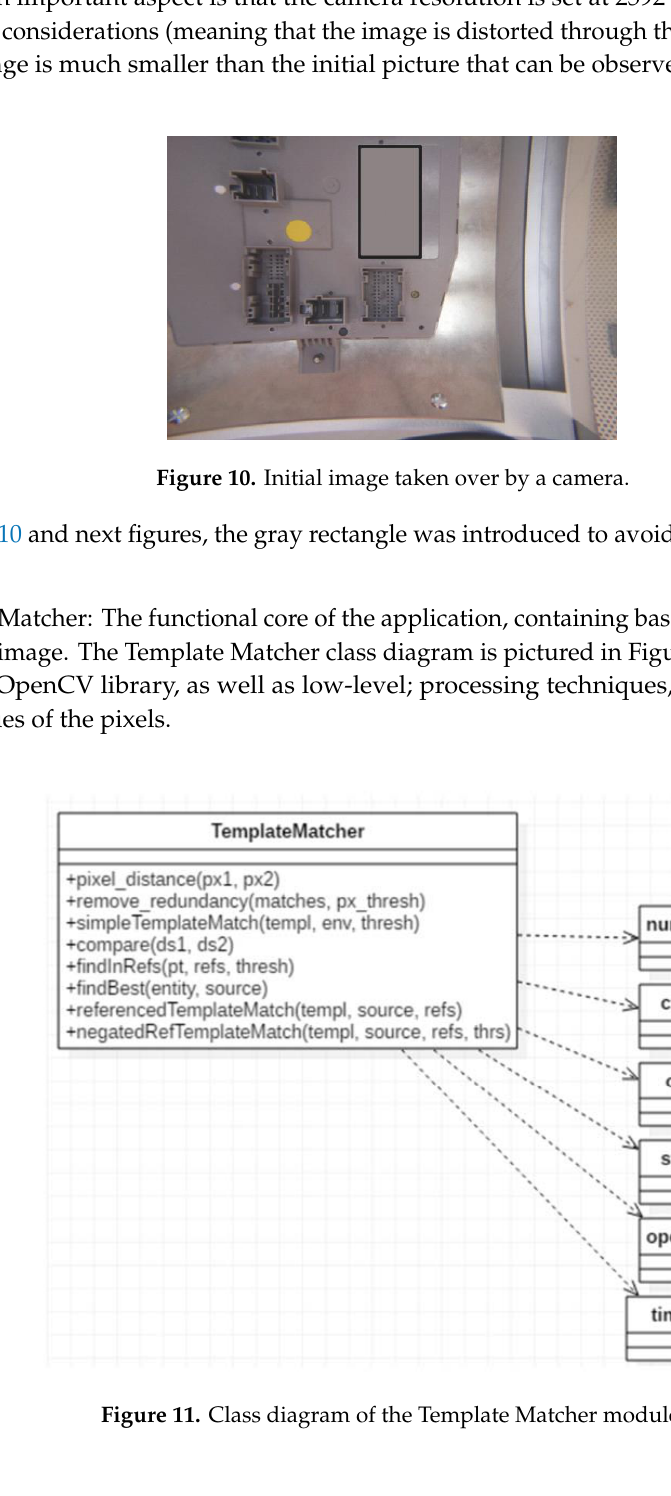
( c ) Figure 12. Flowchart of the function ( a ) referencedTemplateMatch; ( b ) findBest; ( c ) compare.